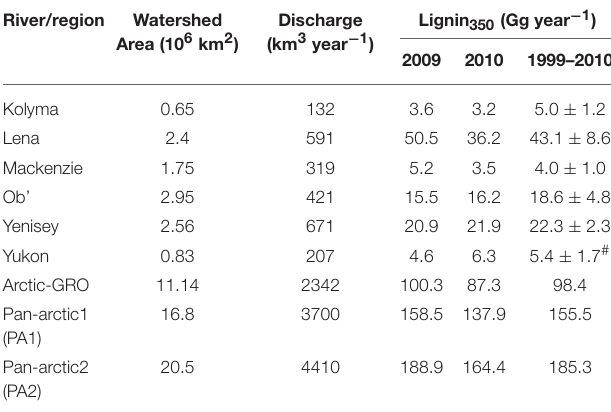
TABLE 5 | Total annual mean fluxes of CDOM-derived lignin (Lignin 350 ) and DOC calculated using